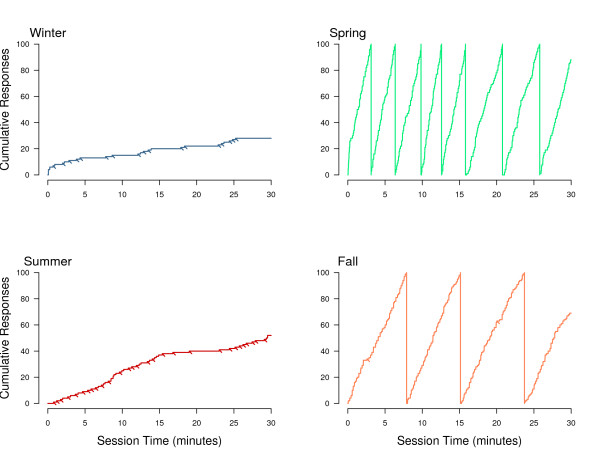
Cumulative records for an individual bird from a single session during each season. Diagonal lines extending directly beneath the record (hash marks) indicate food reinforcement. Note there are no reinforcements earned during the spring season. Vertical lines extending from 100 to 0 responses (spring and fall only) are resets of the "pen" due to high rates of responding; this was done to keep the scale constant across each of the four records.